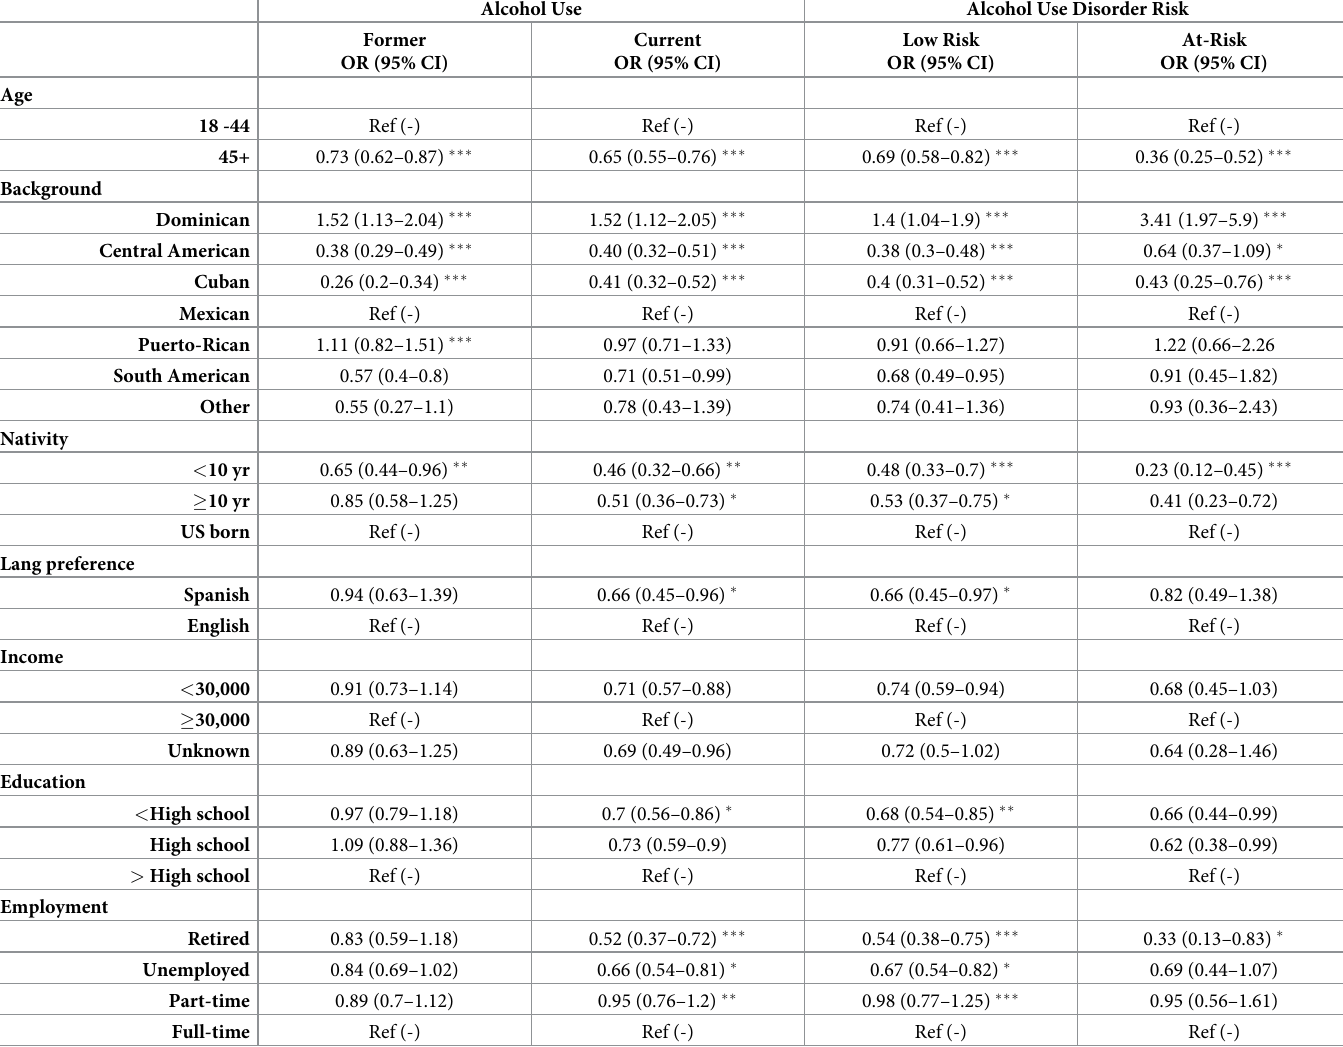
Table 2. Multinomial logistic regression assessing the relationship between alcohol use and related risk behavior and socio-demographic variables and accultura- tion for women (n =